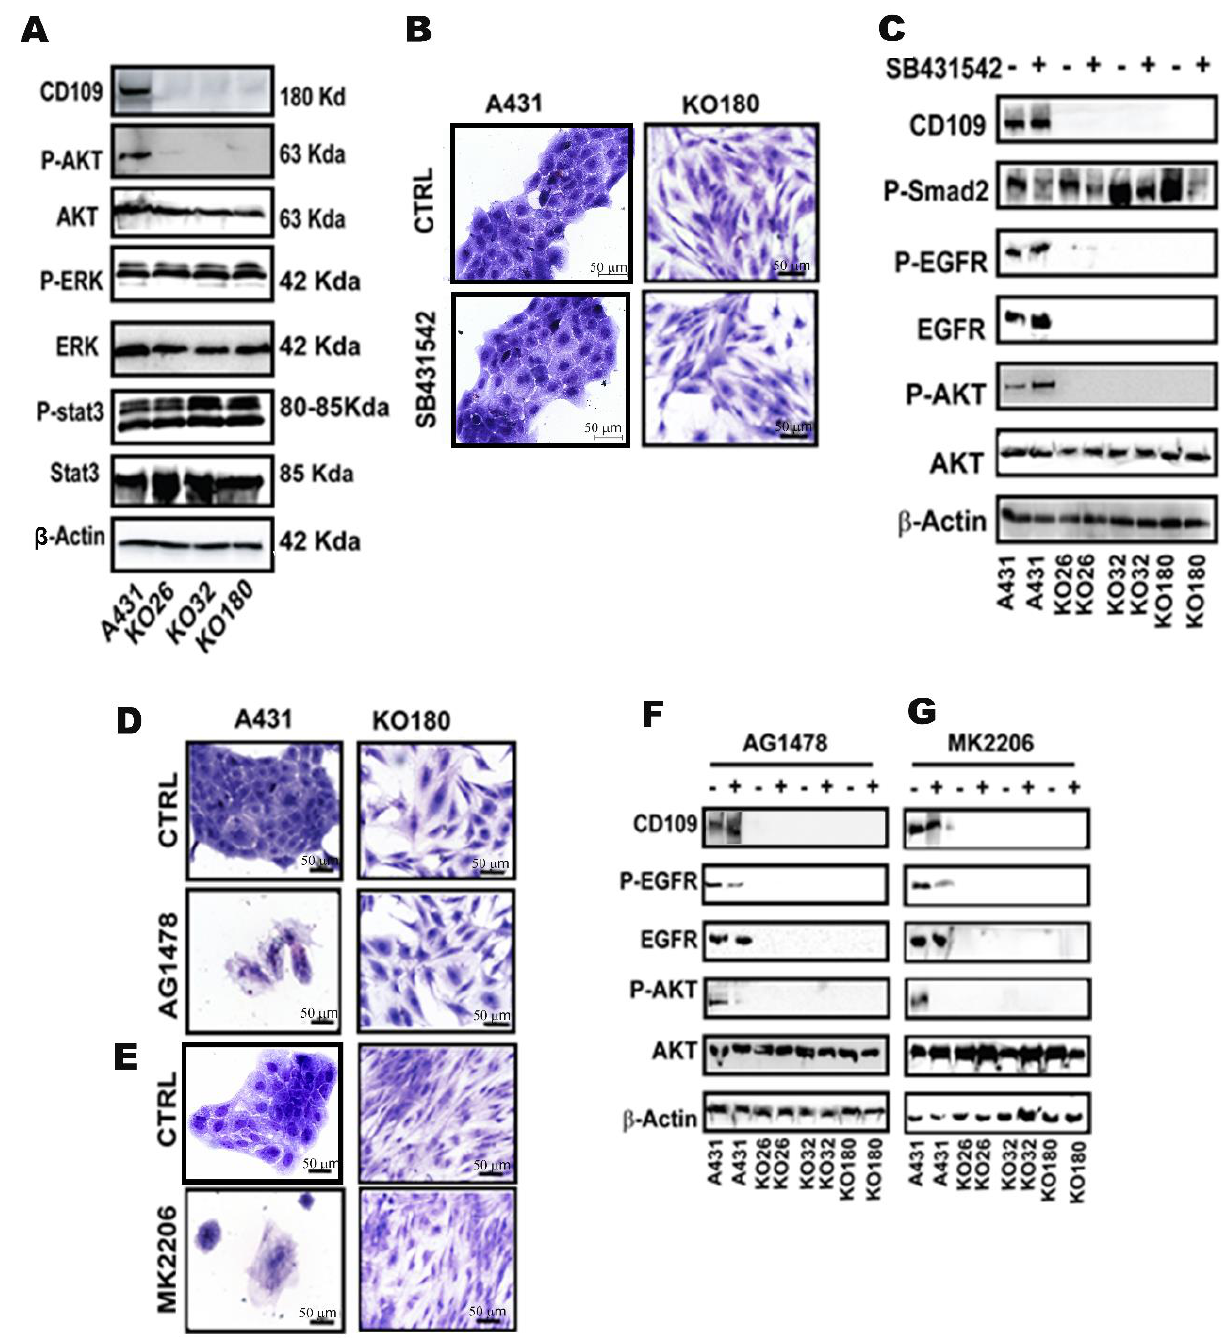
Figure 5. The AKT pathway, but not the ERK1/2 and STAT3 pathways, is inactivated in CD109 KO SCC cells, while in control SCC cells, EGFR kinase inhibition phenocopies AKT inhibition in inducing cell death and CD109KO-like mesenchymal state. ( A ): Western blot analysis for the indicated proteins in control A431 cells and CD109KO A431 clones. ( B ): Representative images of Toluidine blue staining for control A431 cells and CD109KO A431 treated with or without 10 µ M TGF- β inhibitor SB431542 for 72 h. ( C ): Western blot analysis of cells in for the indicated proteins. ( D , E ): Representative images of Toluidine blue staining for control A431 cells and CD109KO A431 cells treated with or without as 5 µ M/L EGFR inhibitor AG1478 ( D ) or AKT inhibitor MK2206 ( E ). ( F , G ): Western blot analysis of the control A431 and CD109KO A431 cells treated with or without 5 μ M/L AG1478 ( F ) or 5 µ M/L MK2206 ( G ) for 20 h. All the results were repeated in three independent experiments. Scale bar: 50 µ m. Uncropped WB images were shown in Figure S5.